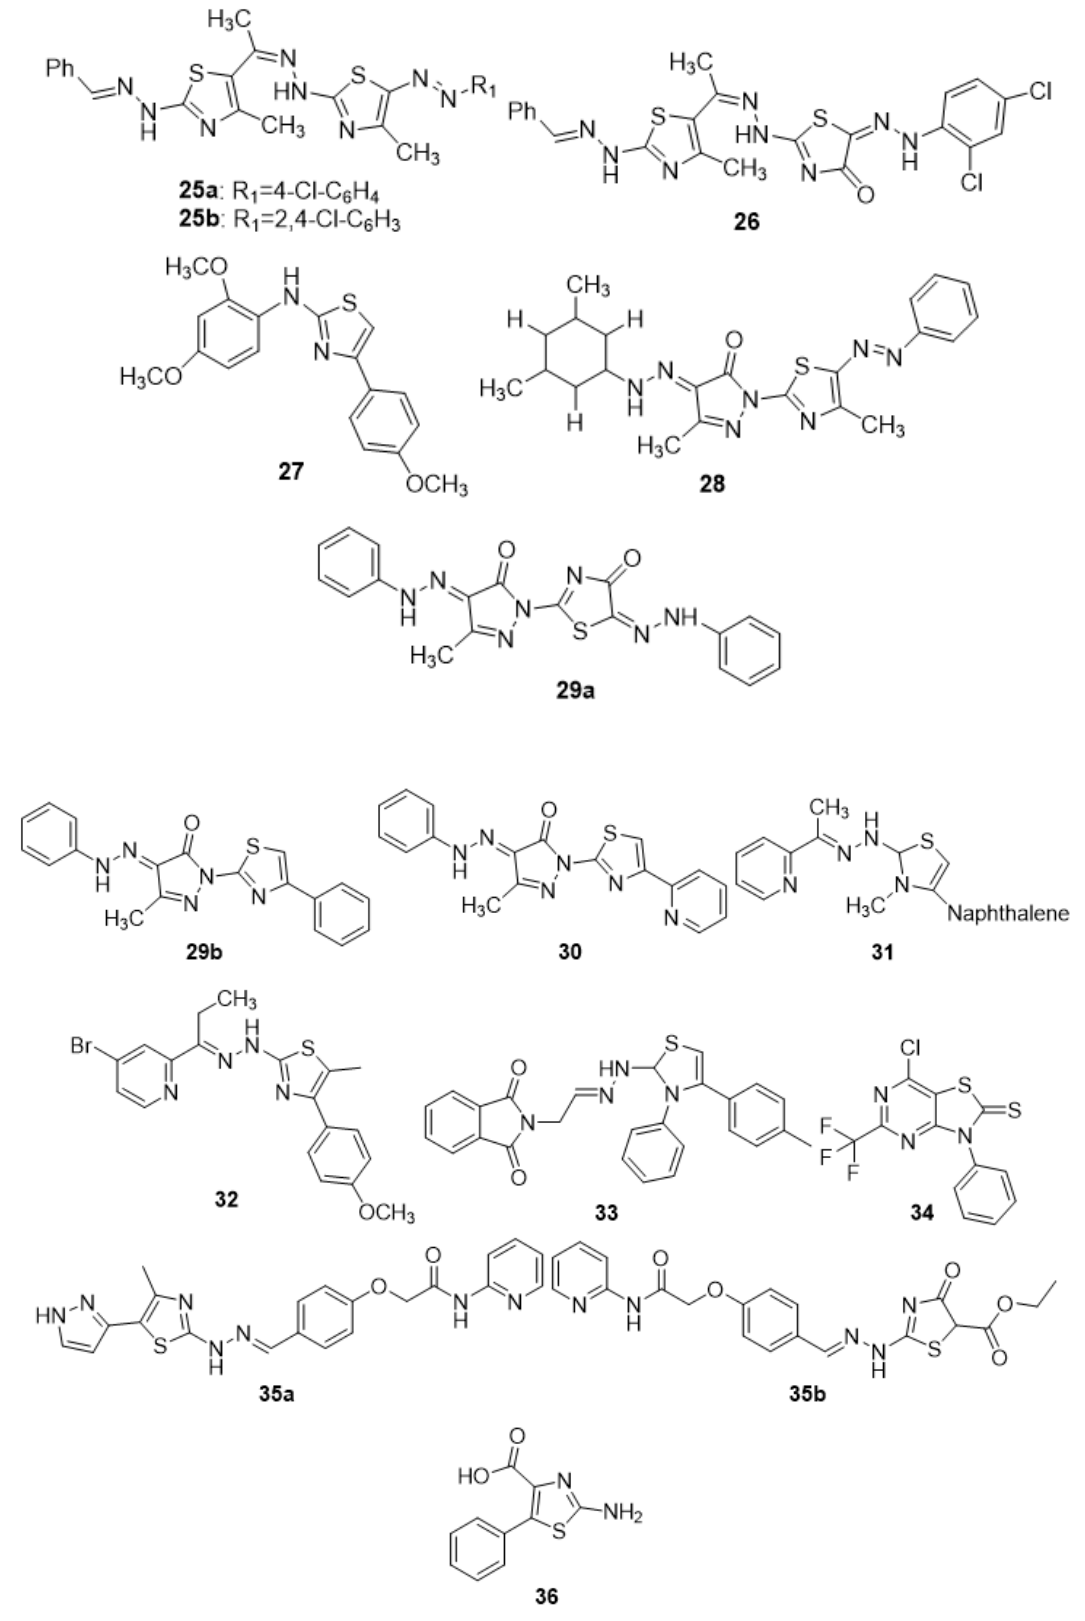
Figure 4. Thiazoles that have recently been designed and produced as possible anticancer agents.